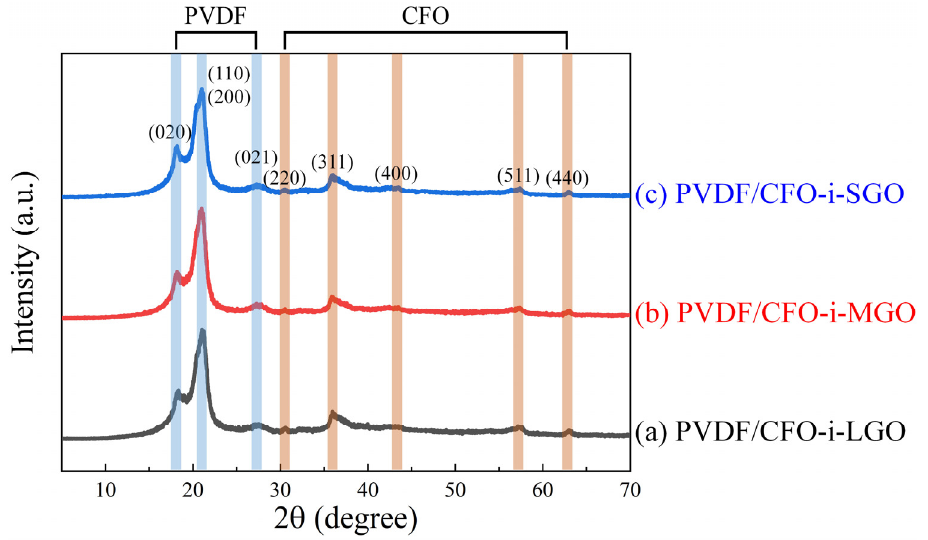
Figure 7. XRD patterns of the 3-2 type ME films of ( a ) PVDF/CFO-i-LGO, ( b ) PVDF/CFO-i-MGO, and ( c ) PVDF/CFO-i-SGO.